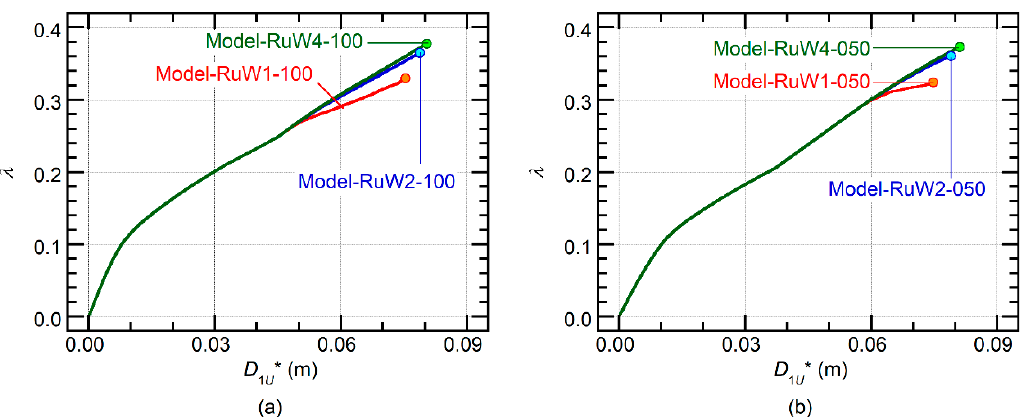
Figure 26. Comparison of the evaluated results of the capacity index considering the bidirectional ground motion: ( a ) Models RuW1-100, RuW2-100, and RuW4-100, ( b ) Models RuW1-050, RuW2-050, and RuW4-050.